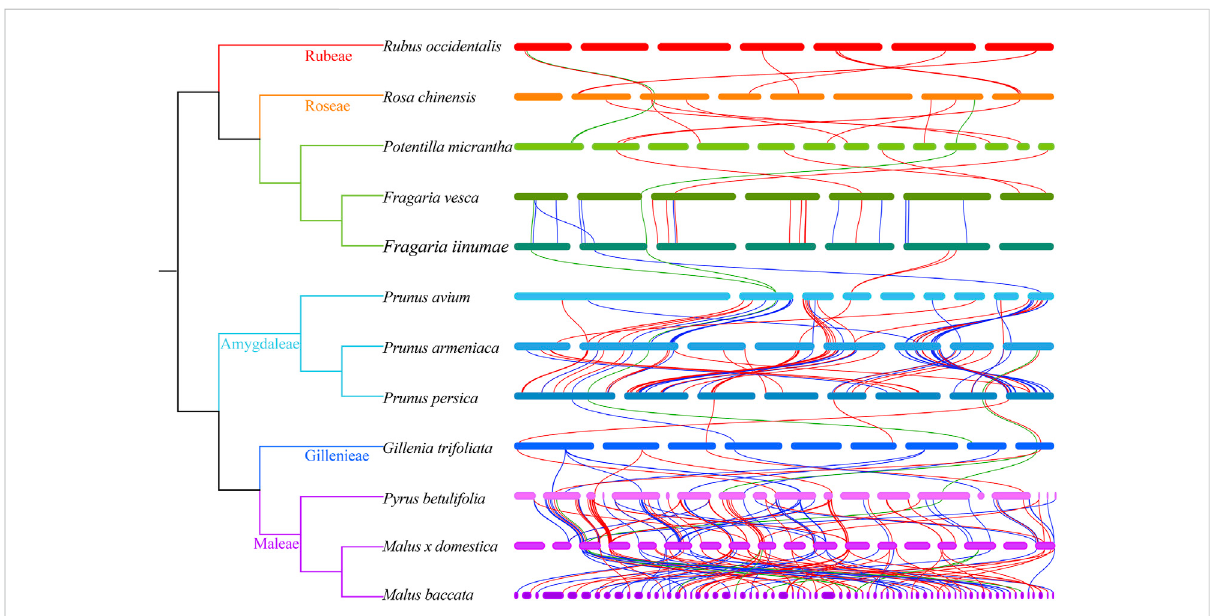
FIGURE 6 Collinearity of NBS-LRR genes between closely related Rosaceae species. The green, blue and red lines show the collinear gene pairs of RNLs , TNLs and CNLs between 12 Rosaceae